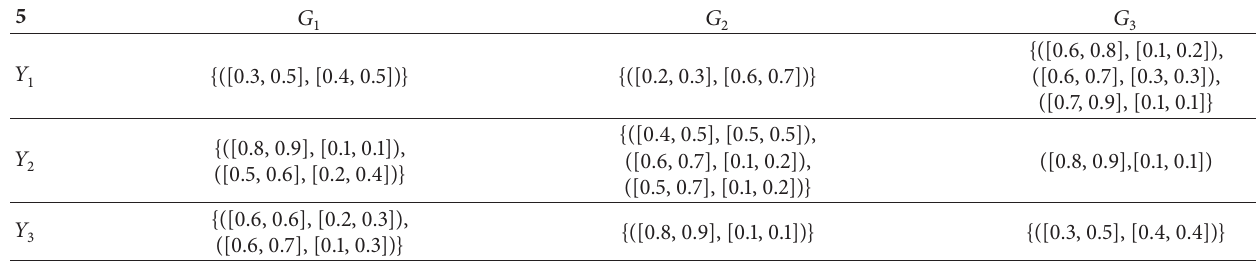
Table 5: The interval-valued intuitionistic hesitant fuzzy decision matrix